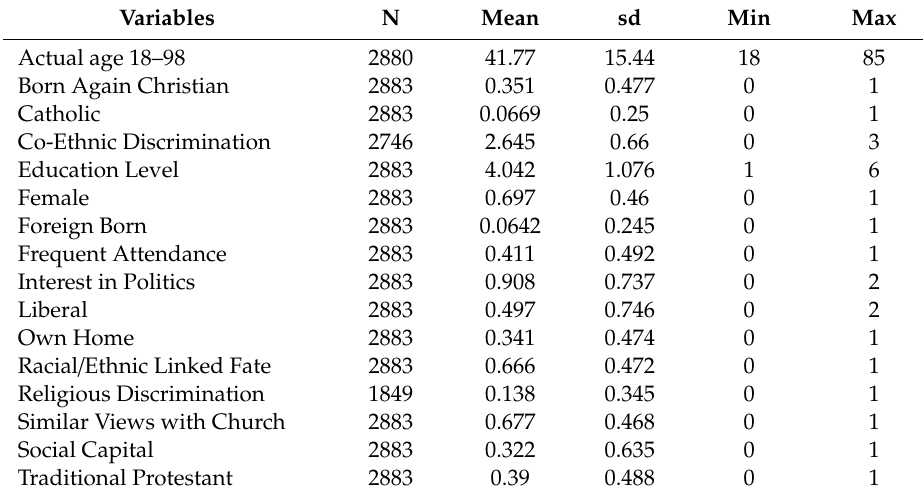
Table 2. Black respondents’ summary statistics.